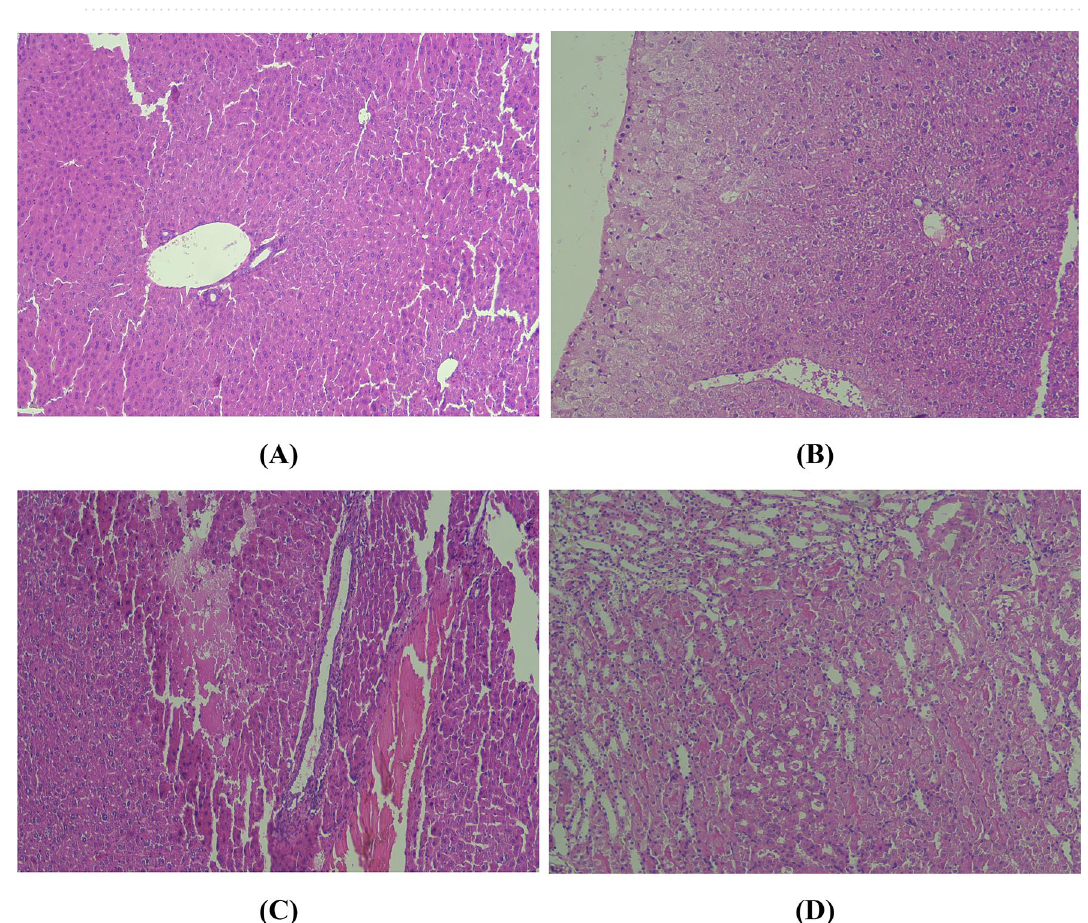
Figure 2. The histopathological effects of CH and DZN on the BALB/c liver in studied groups. The mice liver section in the control group ( A ). As the microscopic findings showed, DZN induced focal necrosis in an acute inflammation with infiltration of granulocytes and mononuclear cells in liver tissue ( B ). Furthermore, the clostasis was observed in the liver section ( C ). While, whereas CH in the highest concentration (50 mg/kg) was able to nearly reduce the toxic effects of DZN in the DZN plus CH group ( D ). Hematoxylin and Eosin (H&E) staining, × 400